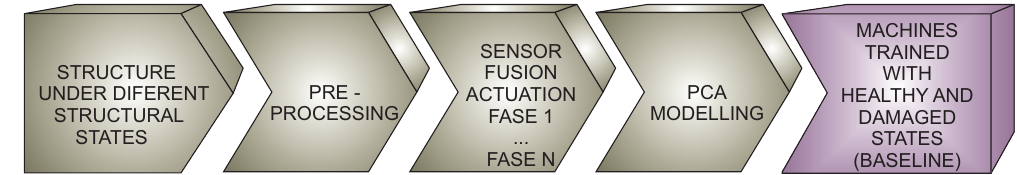
Figure 8. Training process with the data from the structure under different structural states.